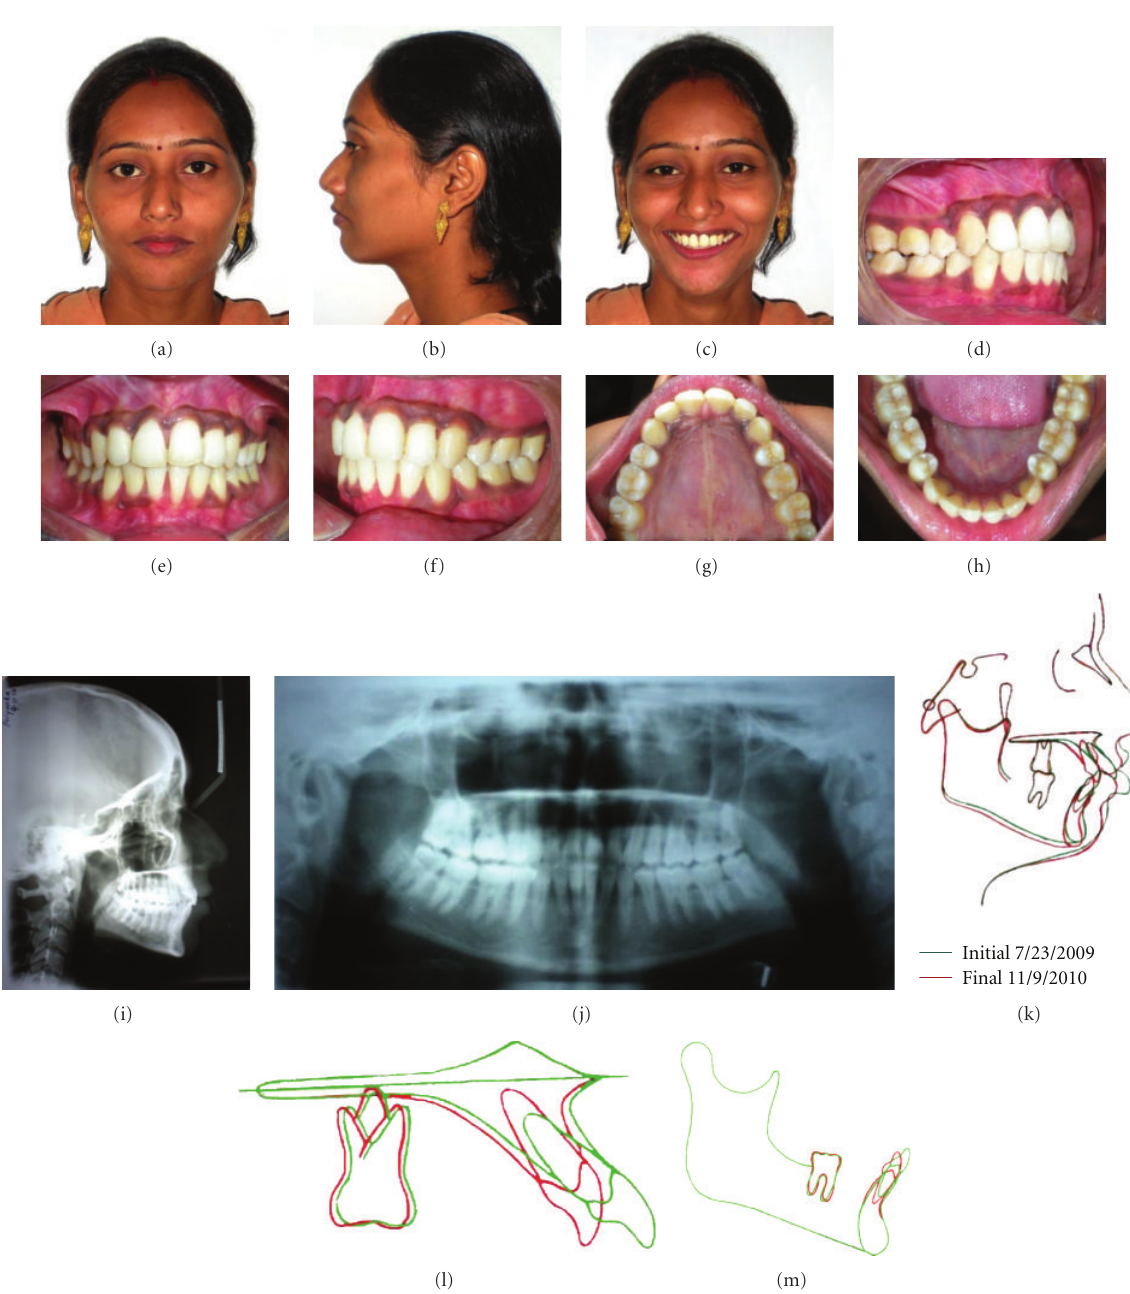
Figure 12: (a–j) Posttreatment photographs and radiographs. (k) Overall pre- and posttreatment superimposition depicts profile improvements. (l, m) Maxilla and mandible pre- and posttreatment